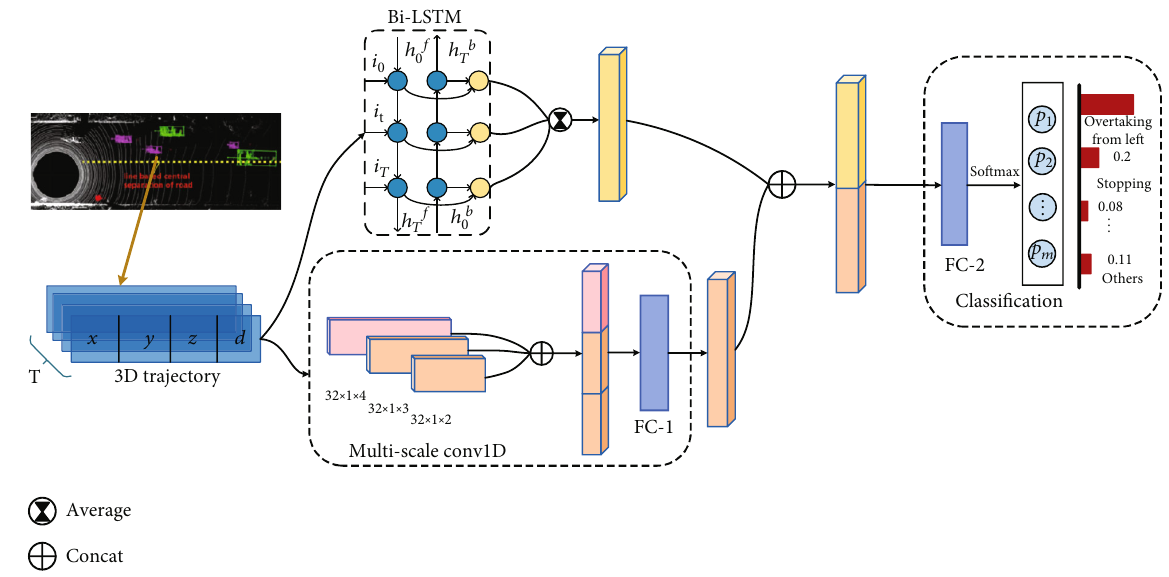
Figure 9: The schematic diagram of the union model